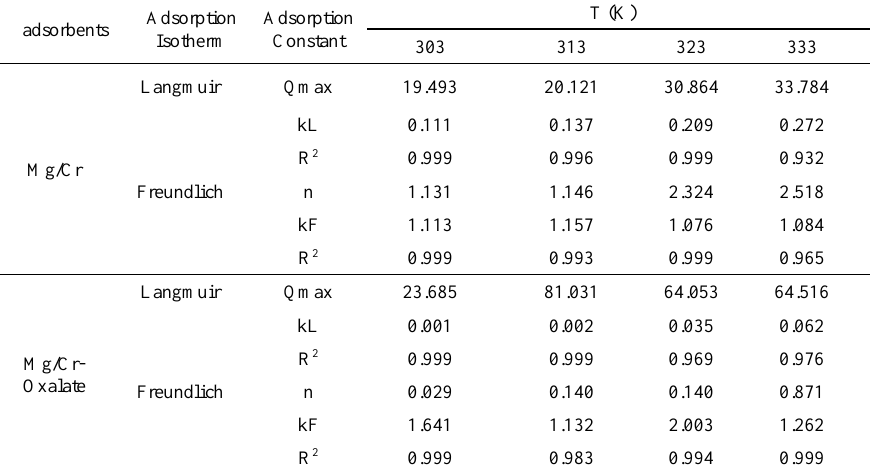
Table 3. Kinetic study of Mg/Cr LDH and Mg/Cr-oxalate LDH